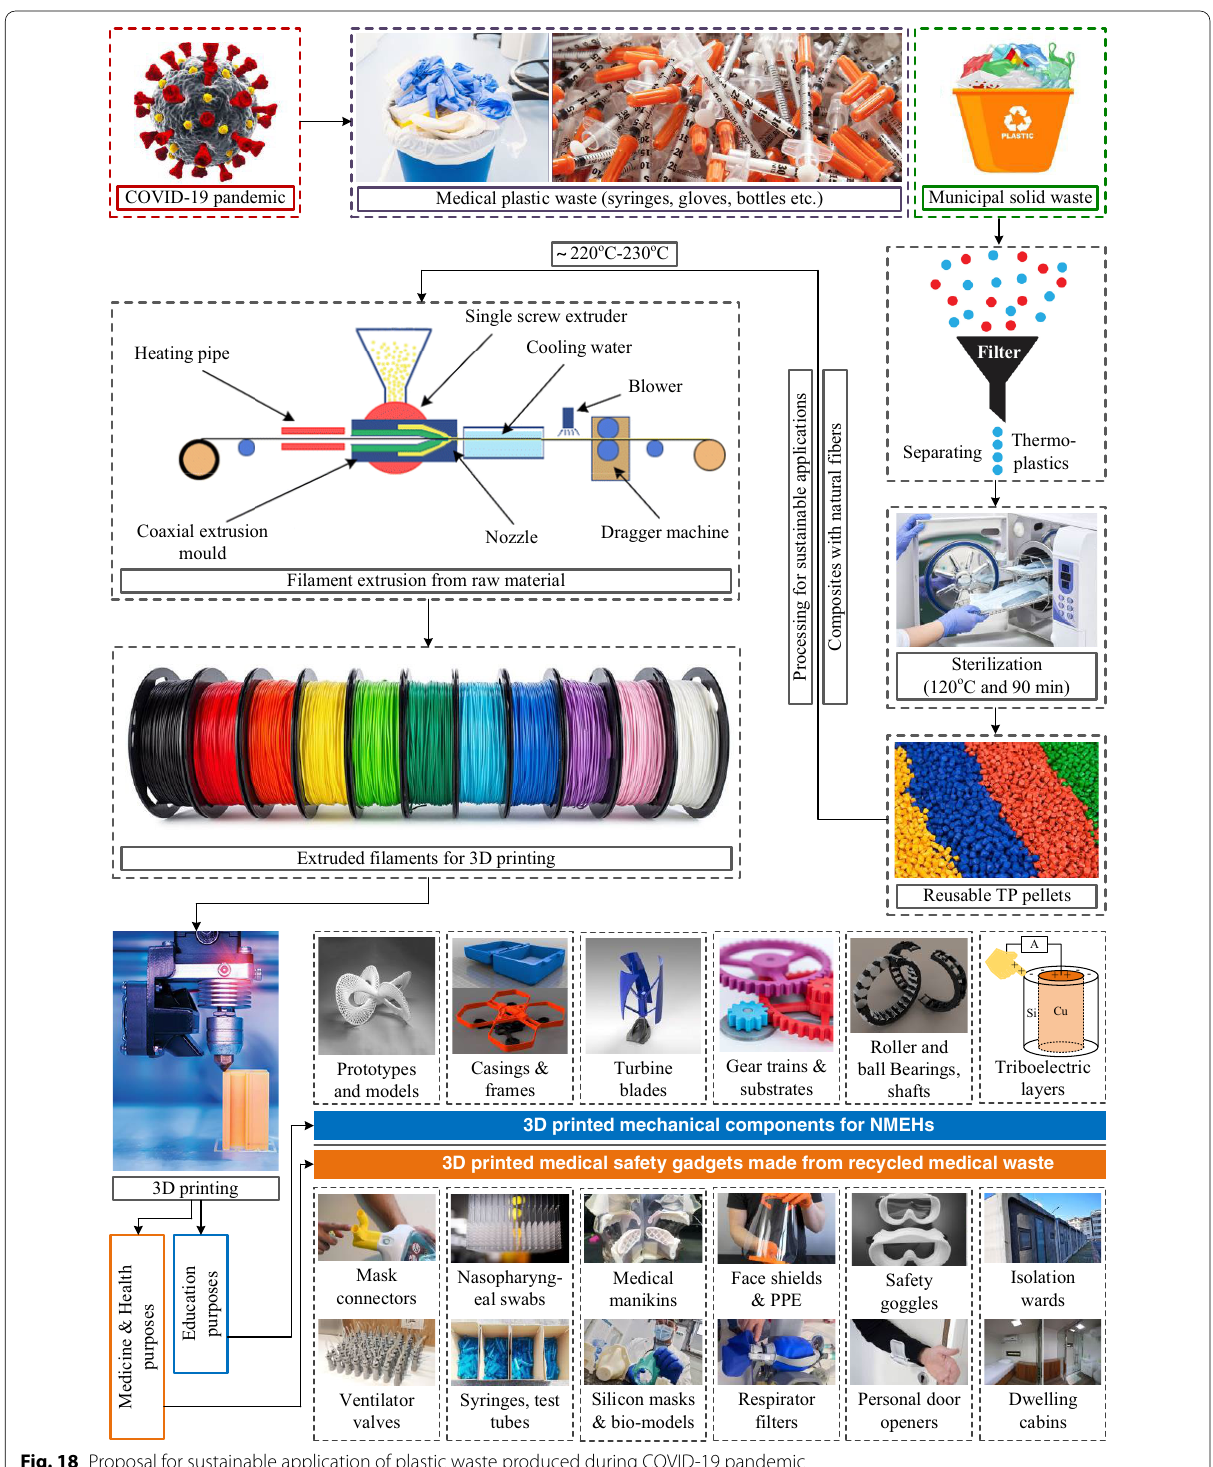
Fig. 18 Proposal for sustainable application of plastic waste produced during COVID-19